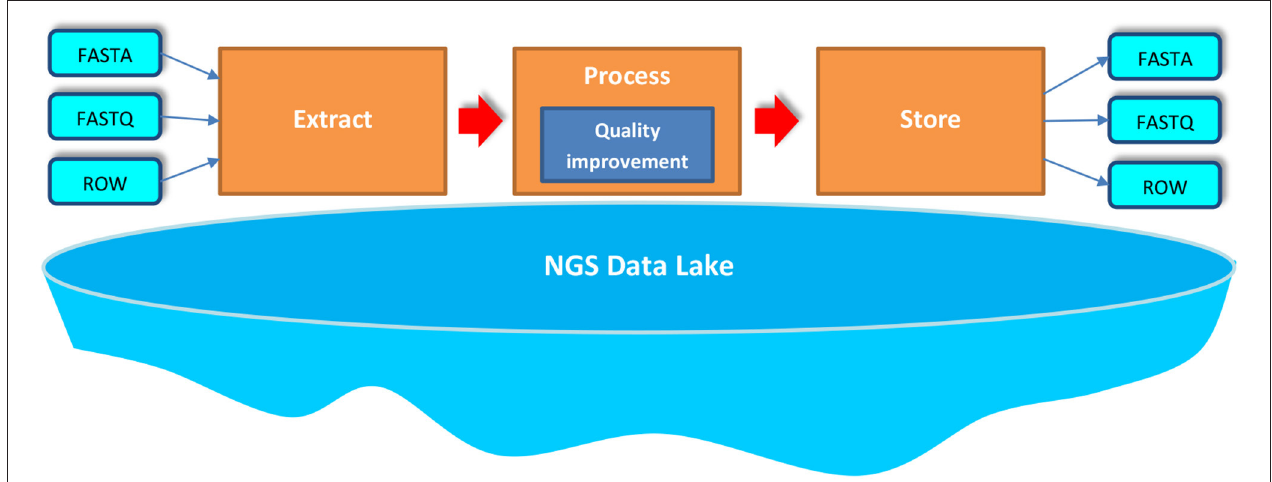
FIGURE 1 | Extraction, processing, and storing (EPS) over big NGS data lake.